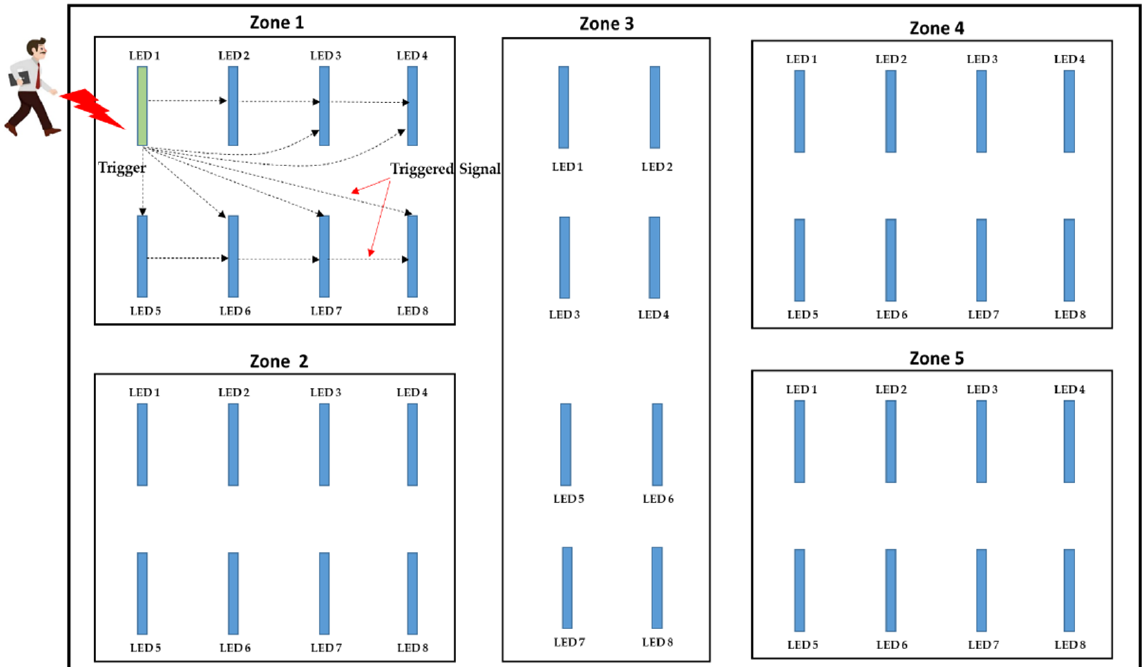
Figure 3. A scenario of the proposed system installed in a large parking lot.